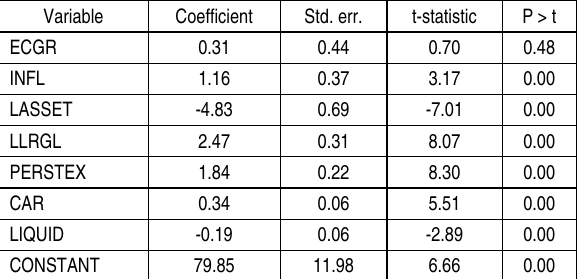
Table 7. The determinant of business